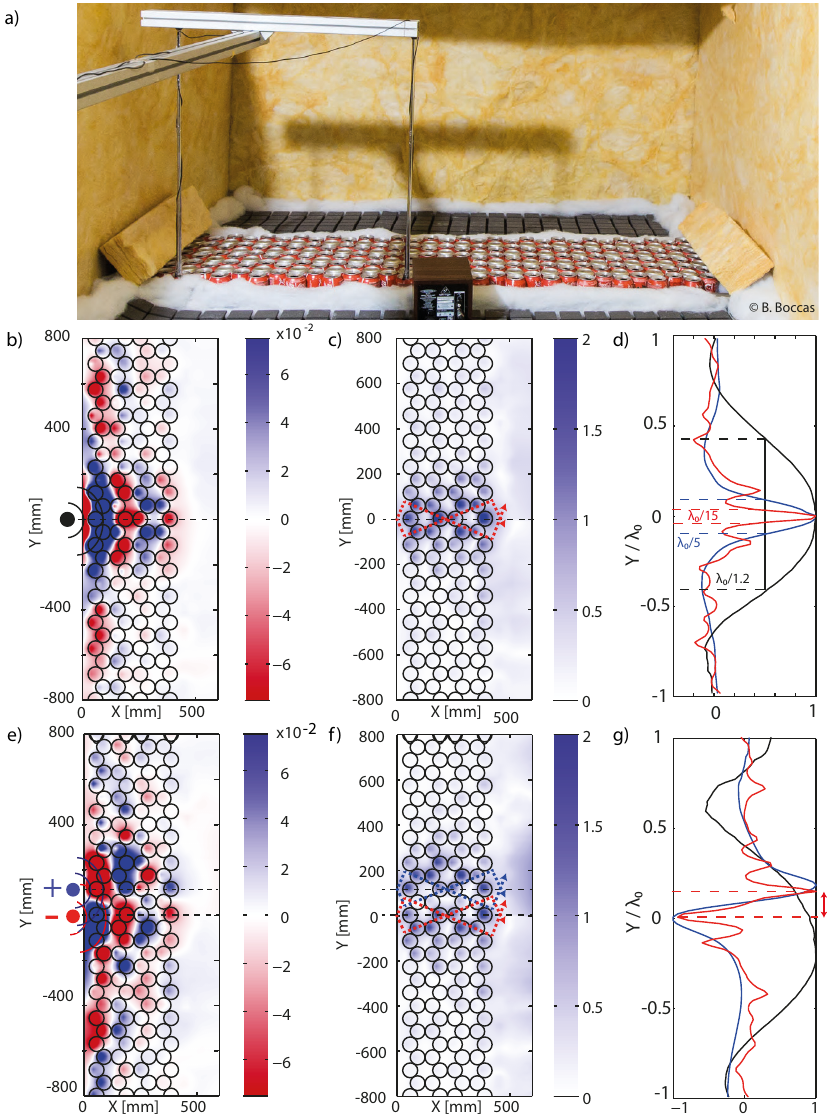
Figure 11. Experimental demonstration of subwavelength focusing and imaging using a flat acoustic lens. ( a ) A photography of the experimental setup: the flat lens, composed of a compact honey comb arrangement of soda cans, is insonified by a loud speaker placed close to the surface of the medium. Two microphones mounted on a 2D moving stage record the acoustic pressure field less than 1 cm away from the top of the cans. Absorbers surround the lens to prevent from undesired reflections; ( b ) The real part of the pressure field at 417.5 Hz and ( c ) its absolute value while compensating for the losses due to the propagation within the lens. The direction of the refracted beams is highlighted with the dashed arrows displaying the features of the negative refraction; ( d ) The normalized amplitude of the field in the close vicinity of the output surface proves a focusing area of λ 0 /15 ( red ) while the source ( blue ) is λ 0 /5 wide and the control experiment ( black ), that is without the lens, λ 0 /1.2 wide. The same experiment is conducted with two sources playing sounds out of phase to demonstrate super-resolution ( e – g ). It clearly proves the same negative refraction results with a resolution of λ 0